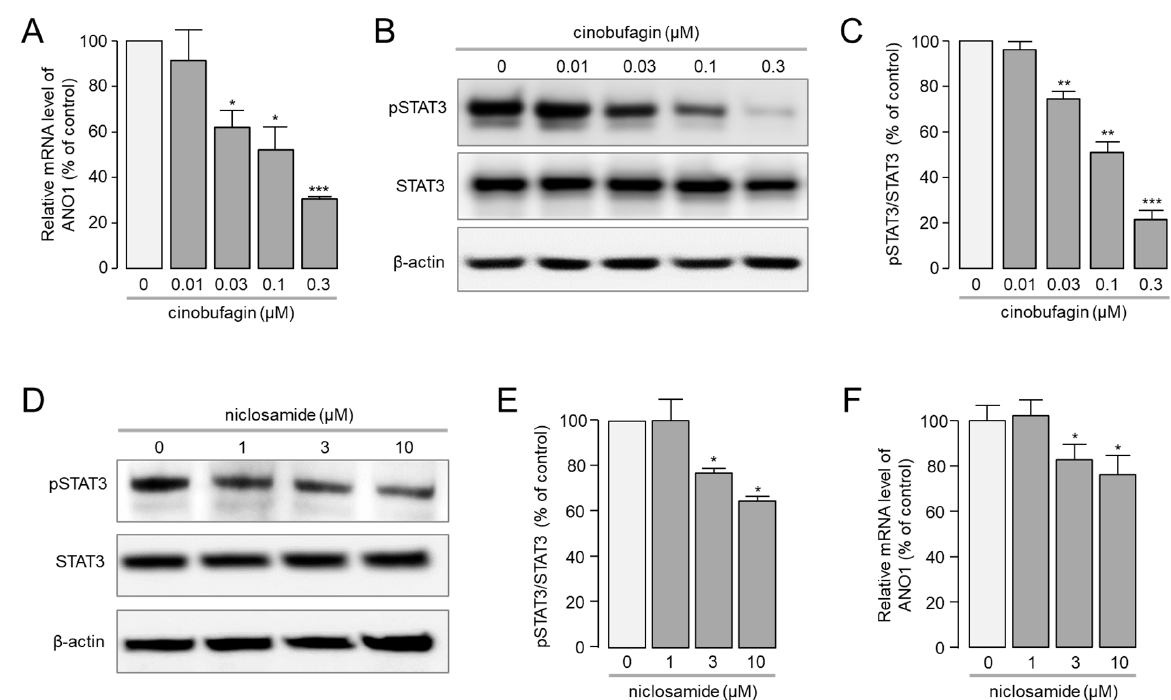
Figure 4. Effects of cinobufagin on mRNA expression level of ANO1 and phosphorylation of STAT3 in CAL-27 cells. ( A ) mRNA expression levels of ANO1 were measured using real-time PCR in CAL-27 cells. Indicated concentrations of cinobufagin were treated for 24 h (mean ± S.E., n = 3). ( B ) Representative immunoblot analysis of pSTAT3 in CAL-27 cells treated with cinobufagin for 24 h. ( C ) Phosphorylated STAT3 (pSTAT3) levels were normalized against total STAT3 levels (mean ± S.E., n = 3). ( D ) Representative immunoblot analysis of pSTAT3 in CAL-27 cells treated with niclosamide at indicated concentrations for 24 h. ( E ) pSTAT3 levels were normalized against total STAT3 levels (mean ± S.E., n = 3). ( F ) mRNA expression levels of ANO1 were measured in CAL-27 cells treated with niclosamide at indicated concentrations for 24 h (mean ± S.E., n = 3). * p < 0.05, ** p < 0.01, *** p < 0.001.